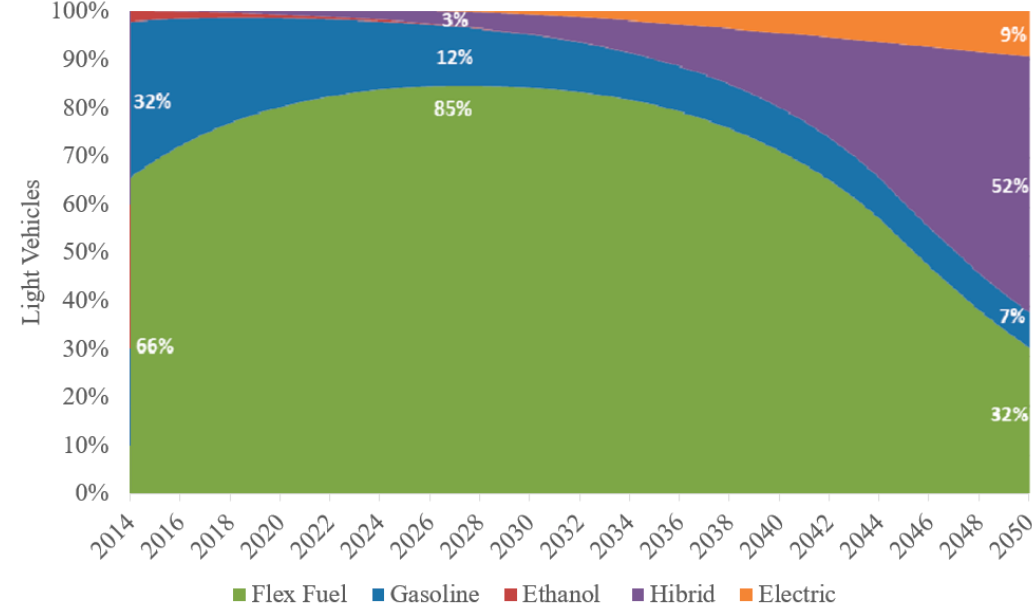
Figure 1. Projected light vehicles fleet profile by fuel in Brazil between 2014 and 2050.